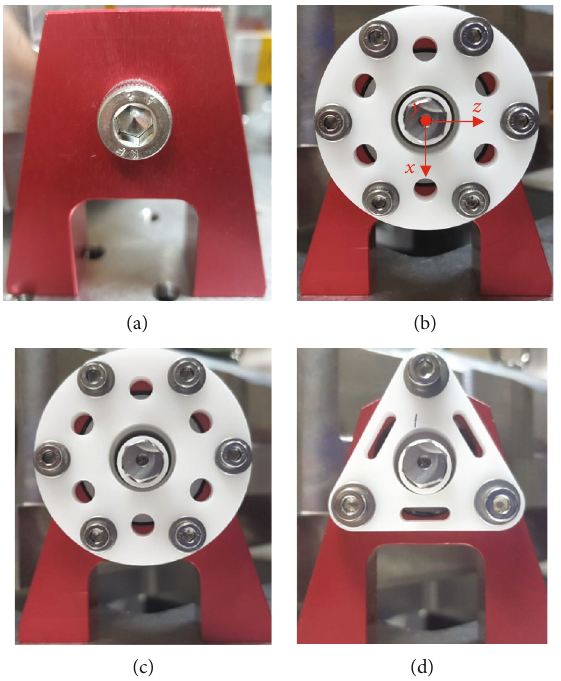
Figure 11: Cooler position for each case ((a) rigidly clamping condition (b) nominal position under 0g (PLOVIS-II), (c) shifted position under 1 g (PLOVIS-II), (d) shifted position under 1g (PLOVIS-I)).